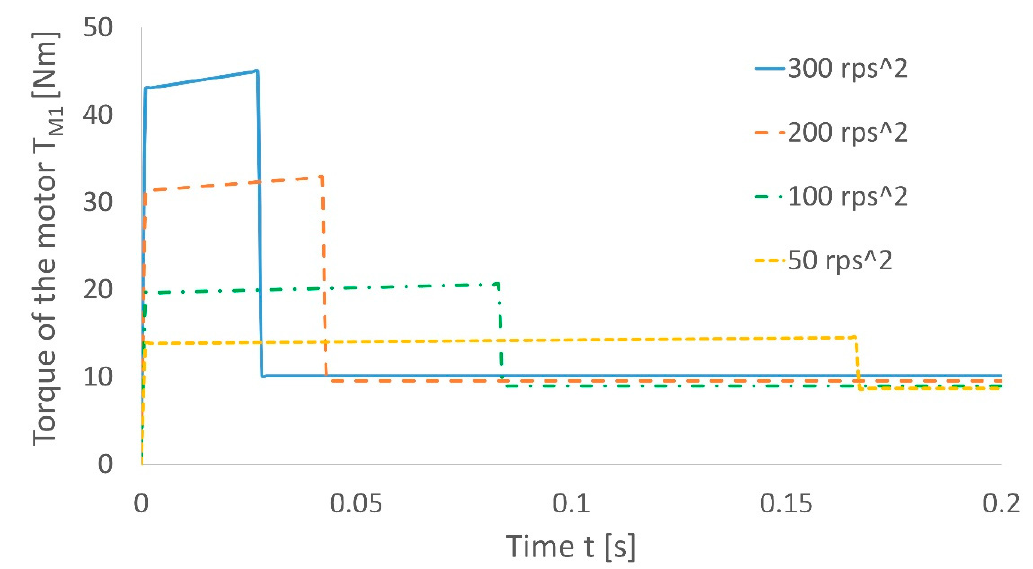
Figure 10. Characteristic curves for the perforating head drive motor torque for various rotational acceleration ε and maximum rotational speed ω = 500 rev/s and assuming uncut strand resistance force of F R = 50 N.